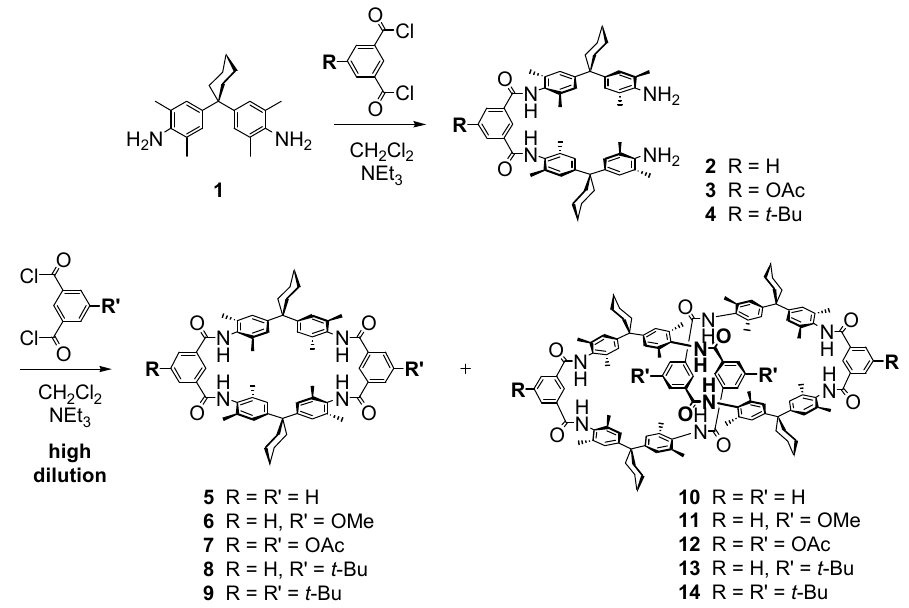
Figure 2. Synthesis of Hunter/Vögtle-type tetralactam macrocycles and the corresponding catenanes. Experimental